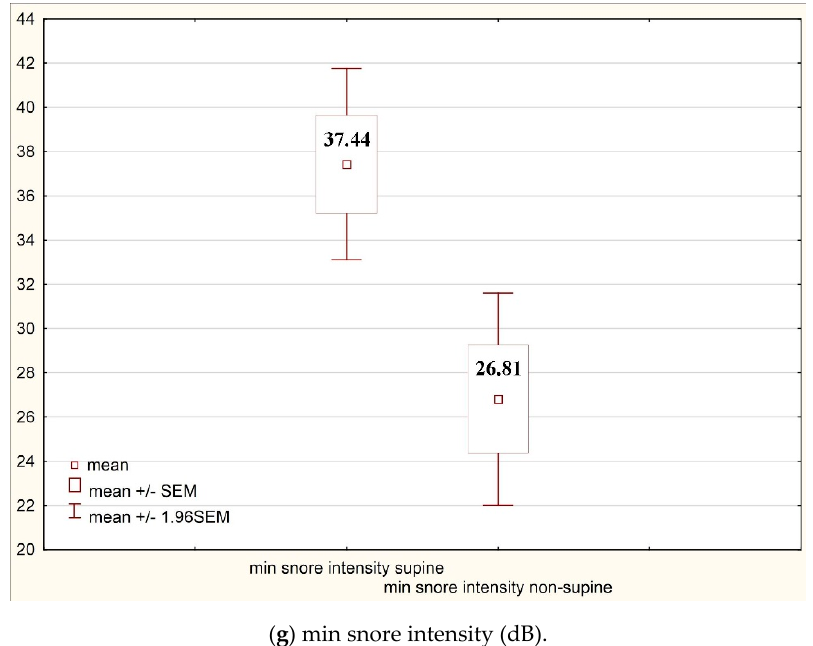
Figure 2. Impact of the body position on snore indices.